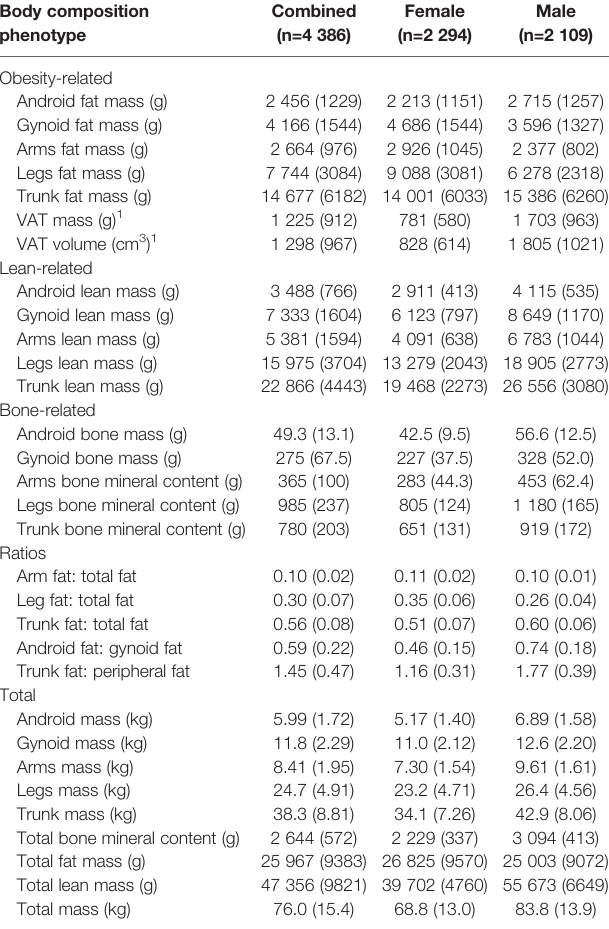
TABLE 1 | Mean (SD) of body composition phenotypes in combined, female and male datasets. Body composition